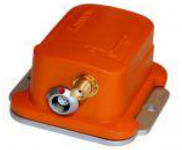
Figure 1. Xsens IMU (taken from taken from www.xsens.com)